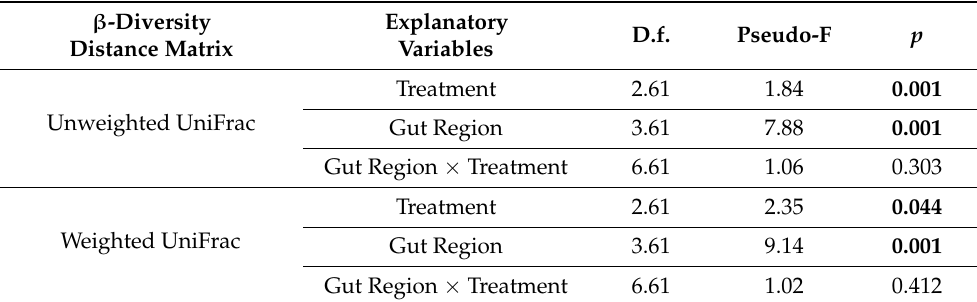
Table 2. General Linear Models exploring the effects of treatment, gut region, and their interaction in beta diversity indices of bacterial community of weaned piglets fed with control diet or supplemented with antibiotic or Allium extract. D.f. refers to degree of freedom. The first number is the degree of freedom of the independent variable and the second one for the error term. Significant p -values are shown in